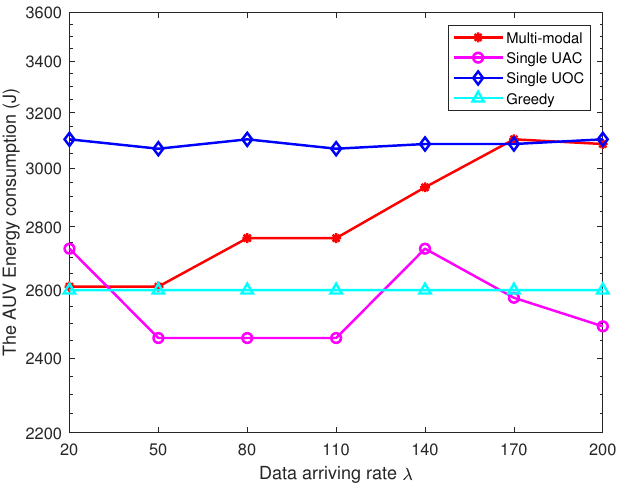
Figure 7. Performance comparison in terms of AUV energy consumption.